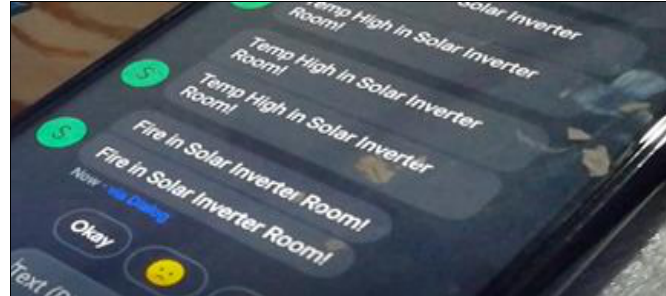
Figure 12: SMS received by the